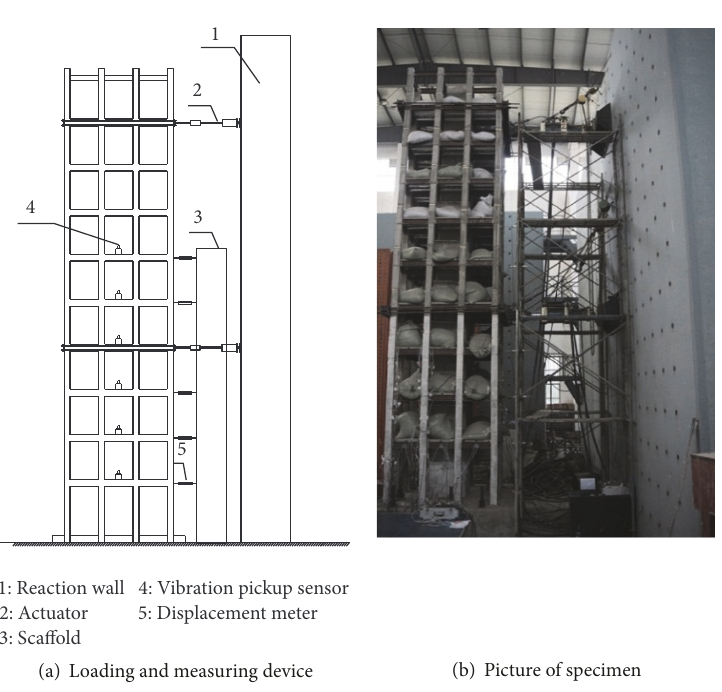
Figure 6: The test